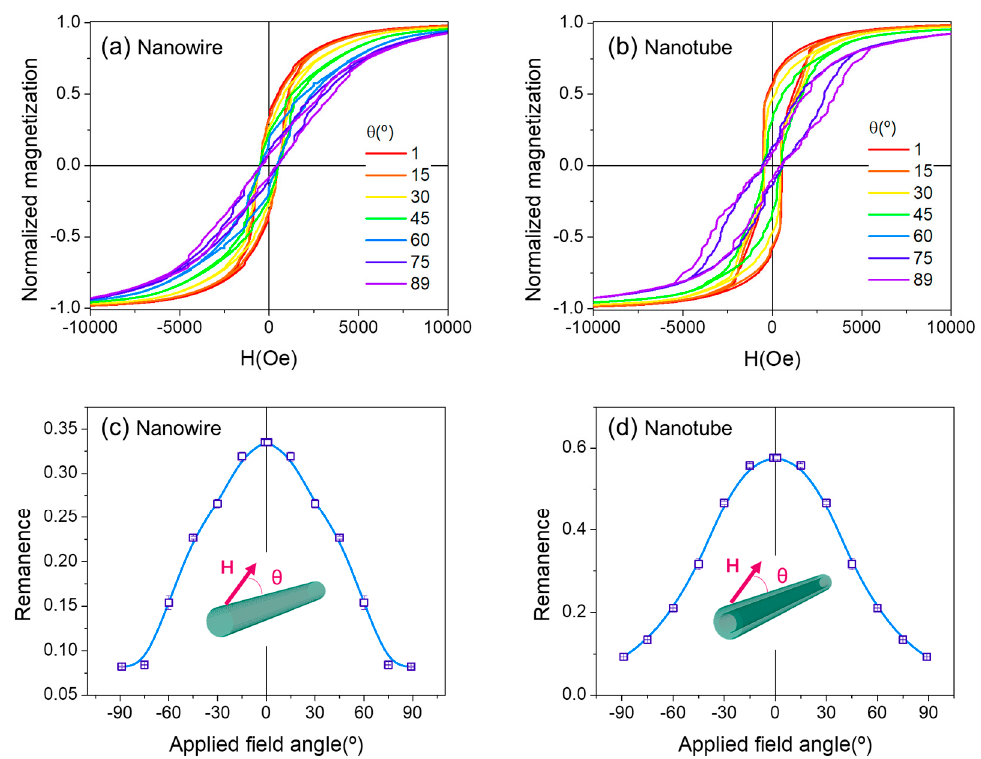
Figure 4. Simulated angular dependence of hysteresis loops for a single nanowire ( a ) and a single nanotube ( b ) and their respective remanence ( c , d ).